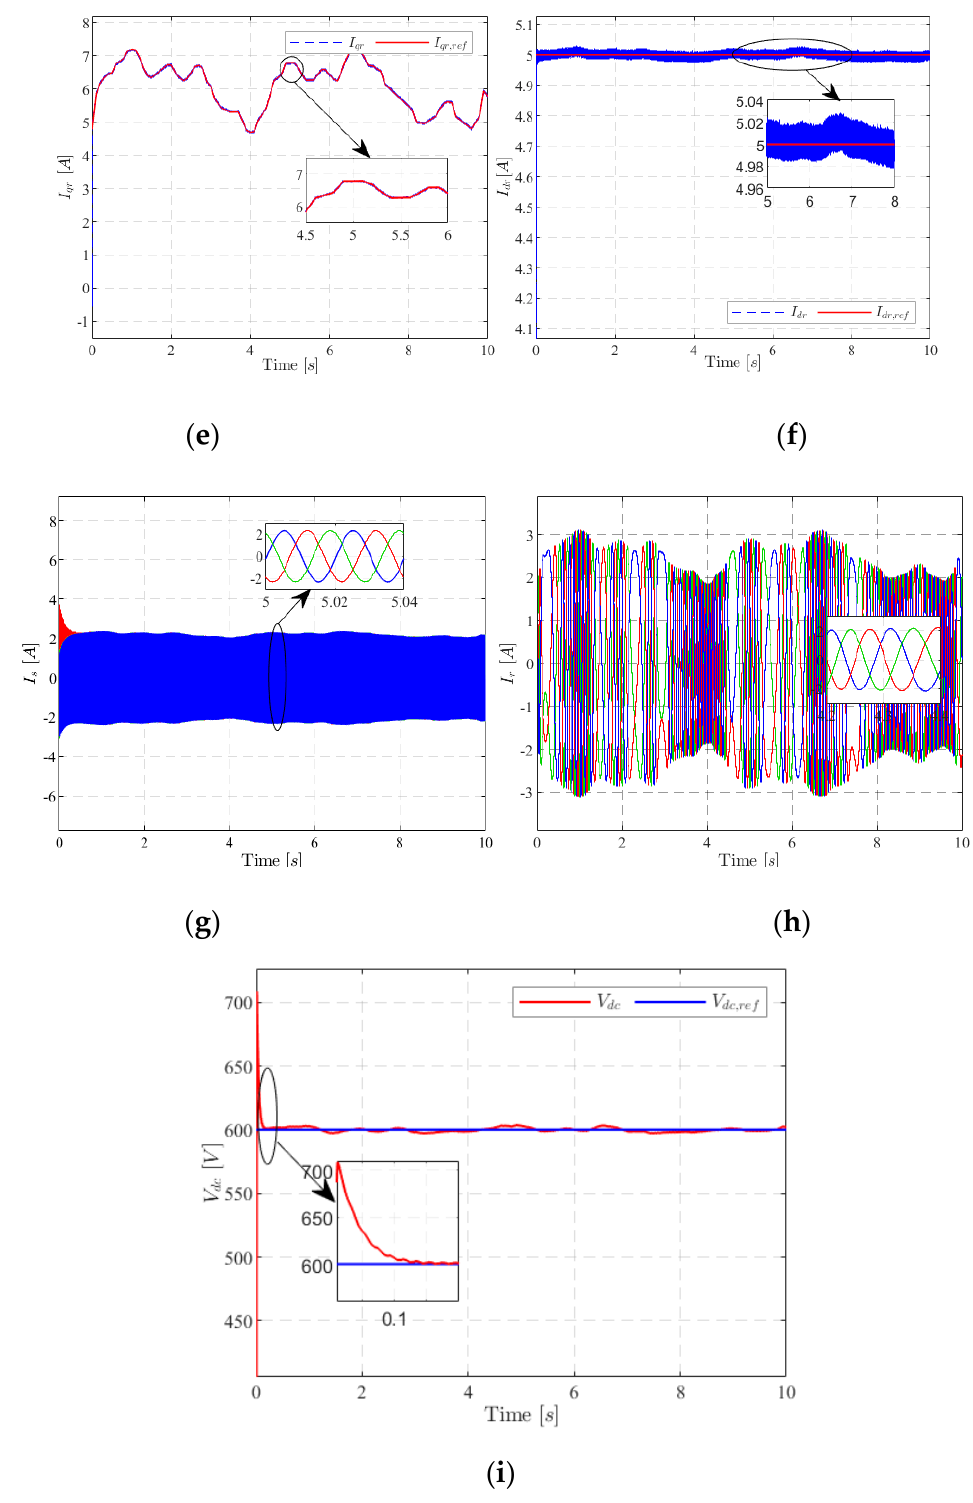
Figure 7. MPC control performance at variable speed: ( a ) The wind profile; ( b ) The electromagnetic torque; ( c ) The active stator power ( d ) The stator reactive power; ( e ) Rotor quadrature current; ( f ) Rotor direct current; ( g ) Stator currents; ( h ) Rotor currents; ( i ) Dc link voltage. Secondly, a fixed random wind profile (Figure 7a) is applied to the system to illustrate the effectiveness of the proposed control with wind